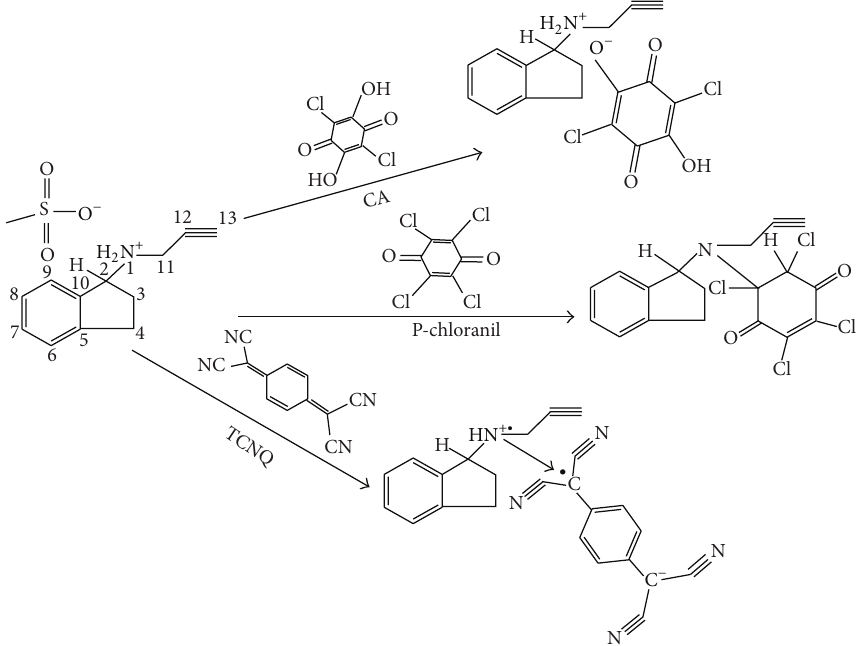
Figure 2: The reaction pathways between RSG and the reactants.